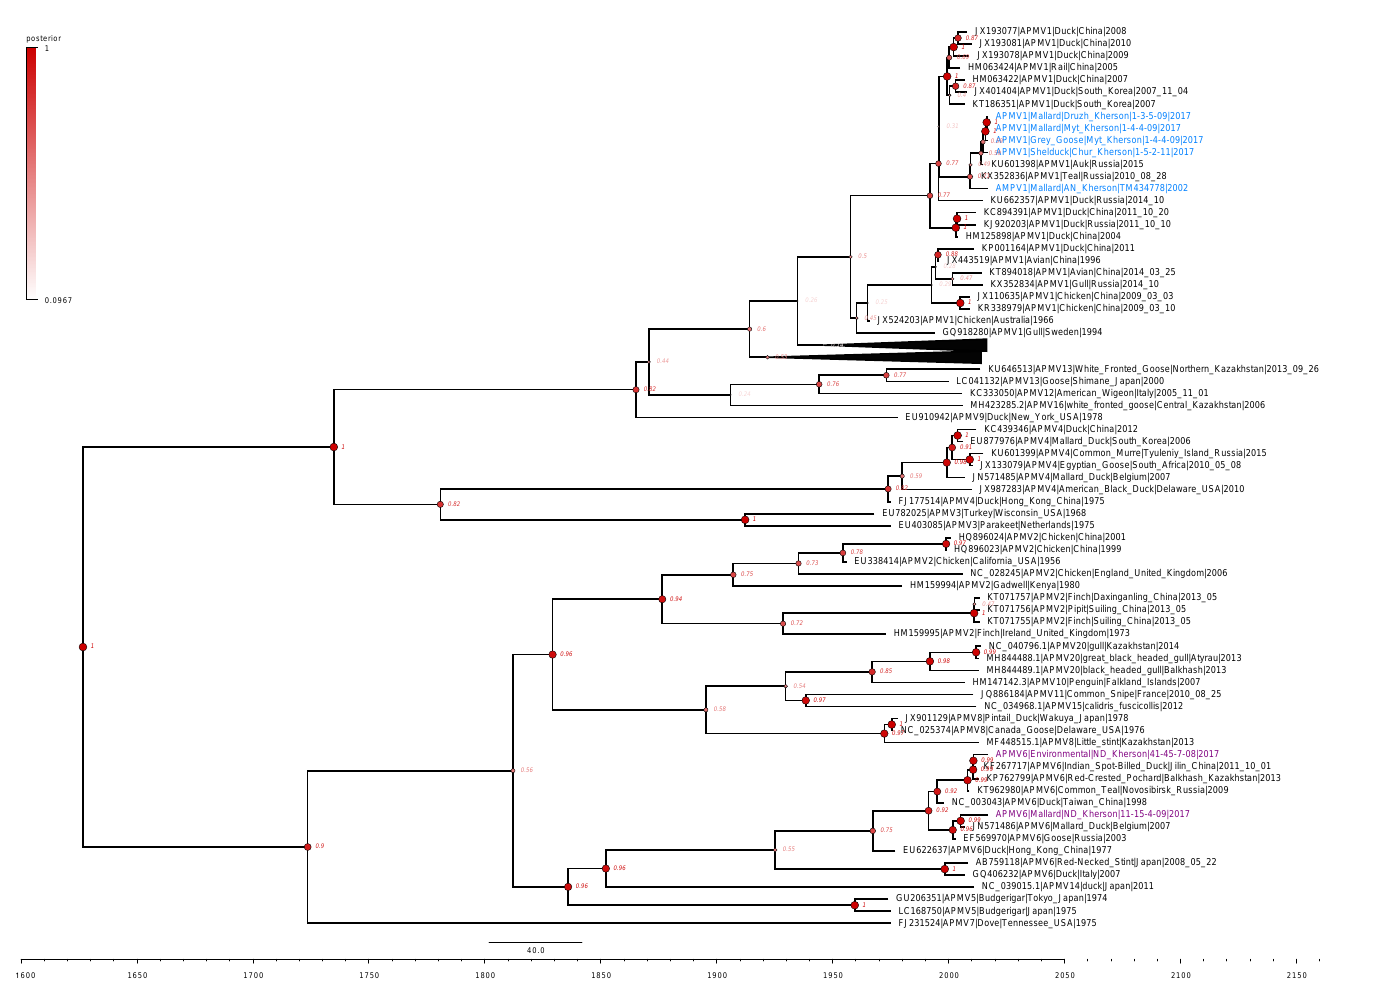
Figure 4. Phylogenetic analysis comparison of all APMV-1 and APMV-6 with APMV strains by a time-scale Bayesian maximum clade credibility tree of 315 APMV reference strains and seven isolated in Ukraine. APMV-1 strains sequenced in this study are highlighted in blue, and APMV-6 are highlighted in purple. Collapsed sequences are APMV-1 subtypes. Nodes indicate posterior probability support with a midpoint tree